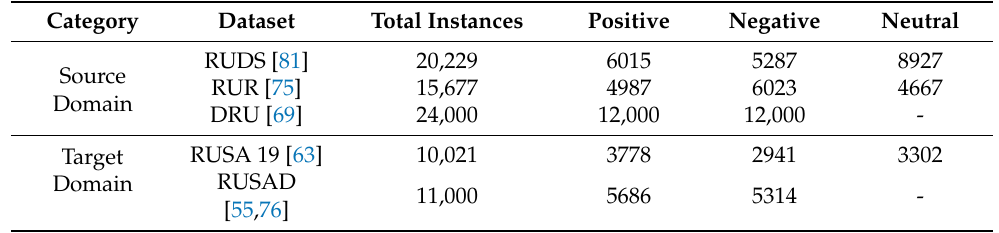
Table 2. Dataset Statistics.